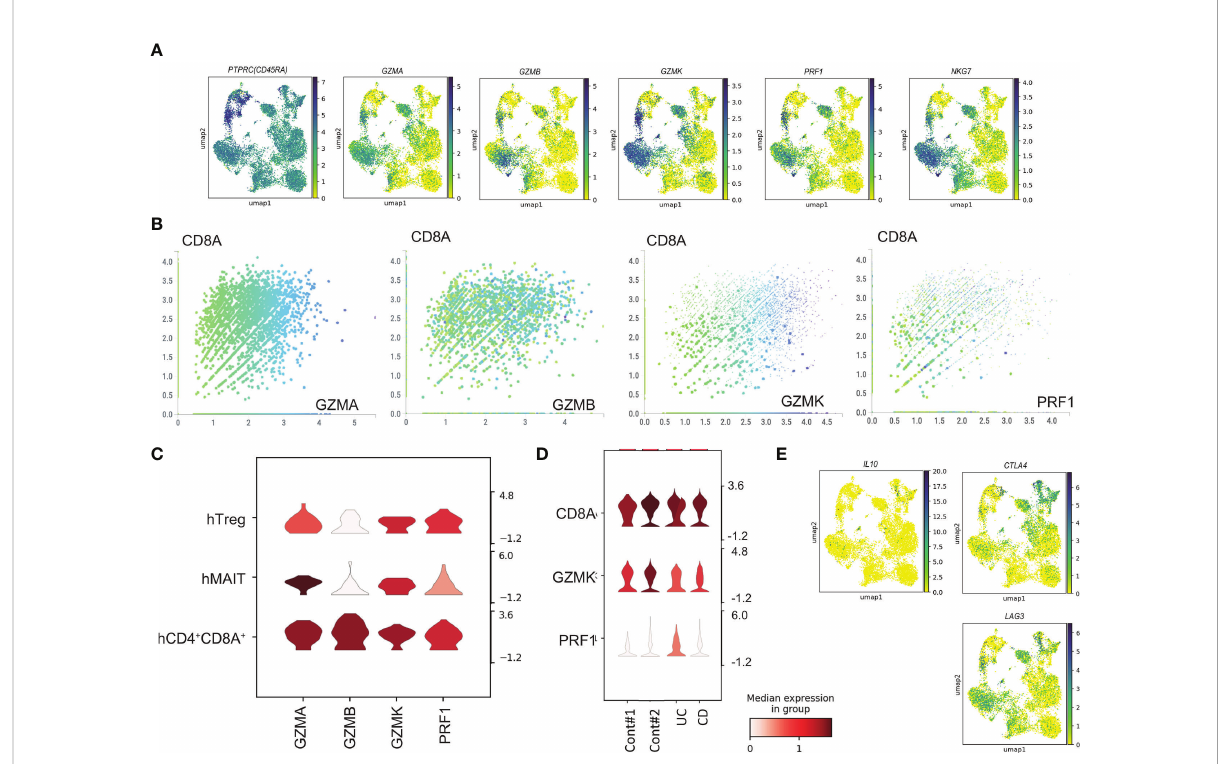
FIGURE 3 Cytotoxic gene expression in human T cells from sc-RNA-seq data. (A) Gene expression of PTPRC, GZMA, GZMB, GZMK, PRF1 and NKG7 in uniform manifold approximation and projection (UMAP) plots using human sc-RNA-seq data. (B) The expression level of CD8A and GZMA, GZMB, GZMK, PRF1 in each cell. (C) The expression level of GZMA, GZMB, GZMK, PRF1 in hTreg, hMAIT, and hCD4 + CD8A + clusters. (D) The expression level of CD8A, GZMK , and PRF1 of CD4+CD8A+ T cells from control, UC and CD patient. (E) Gene expression of IL10, CTLA4 , and LAG3 in uniform manifold approximation and projection (UMAP) plots using human sc-RNA-seq